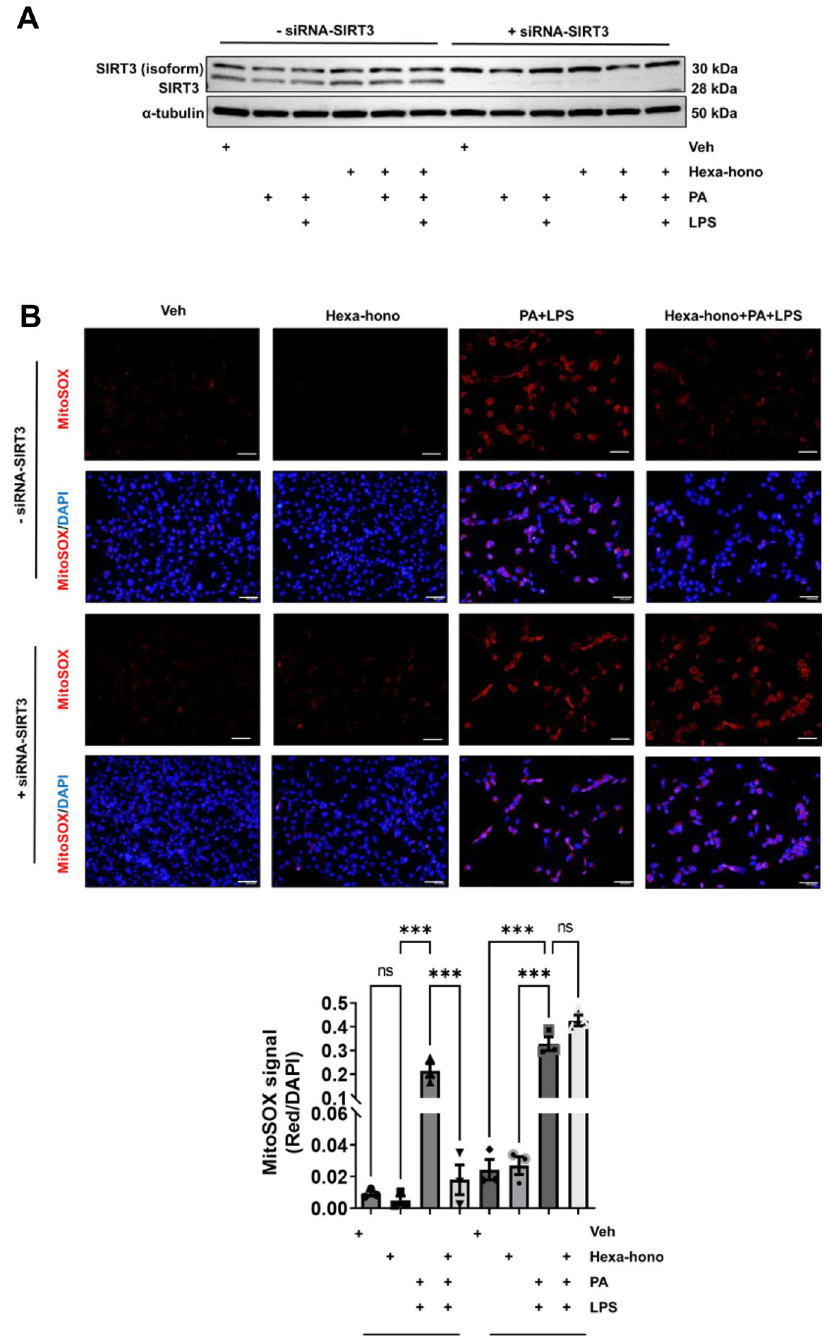
Figure 4. SIRT3 is required for Hexafluoro-honokiol mediated mitochondrial stress reduction in enteric neuronal cells. ( A ) Western blot analysis was performed with protein lysates from control and SIRT3 siRNA transfected IM-FEN cells that were treated with vehicle, PA, PA with LPS, Hexafluoro-honokiol, Hexafluoro- honokiol with PA, Hexafluoro-honokiol with PA and LPS, cultured for 24 h, and probed for SIRT3 protein and α-tubulin as a loading control. ( B ) Determination of mitochondrial superoxide using MitoSOX assay in IM-FEN cells treated with vehicle, Hexa, PA with LPS, hexafluoro with PA and LPS, in IM-FEN cells transfected with control or SIRT3-siRNA. The histogram represents MitoSOX positive cells/DAPI stained cells. The uncropped Western blot images of Fig. 4A have been provided in the supplementary file. Both protein of interest and loading control were run on a single membrane. Data are the mean ± SEM from three independent experiments. ns = non-significant; *** P < 0.001; (2-way